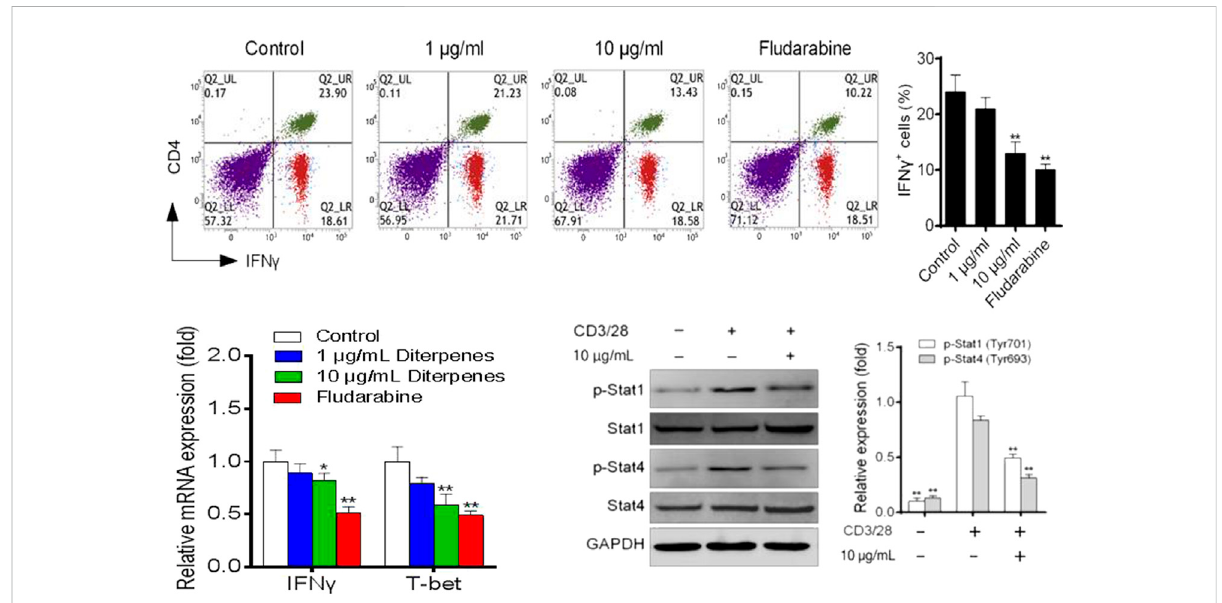
FIGURE 7 Effect of DF on the proportion of Th1 polarized cells, mRNA levels of Th1 transcription factors, and Th1-related STAT